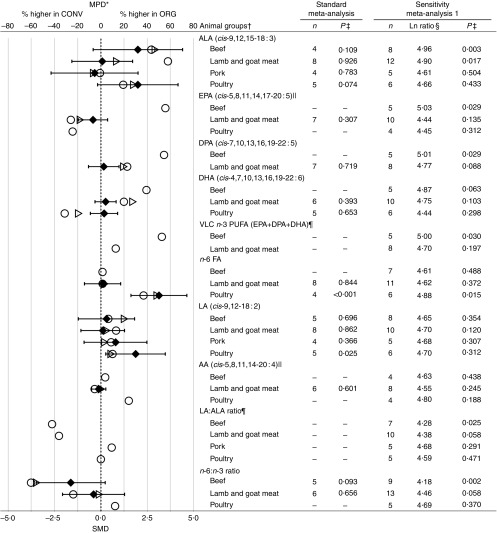
Results of the standard weighted meta-analysis and sensitivity analysis 1 for
different animal groups for fat composition in meat. * Numerical values for mean
percentage difference (MPD) and 95 % CI are given in the online Supplementary Table
S10. † For parameters for which n≤3 for specific animal group,
results obtained in the meta-analyses are not shown. ‡ Ln ratio=ln (ORG/CONV×100 %).
§ P value<0·05 indicates a significant difference between
organic samples (ORG) and conventional samples (CONV). || Outlying data points
(where the MPD between ORG and CONV was more than fifty times greater than the mean
value including the outliers) were removed. ¶ Calculated based on published FA
composition data. n, number of data points included in the
meta-analyses; ALA, α-linolenic acid; DPA, docosapentaenoic acid;
VLC n-3 PUFA, very long-chain n-3 PUFA; FA, fatty
acids; LA, linoleic acid; AA, arachidonic acid; SMD, standardised mean difference;
○, MPD calculated using data included in standard unweighted meta-analyses; ▷, MPD
calculated using data include in standard weighted meta-analysis; ◆, SMD with 95 %
CI represented by horizontal bars.